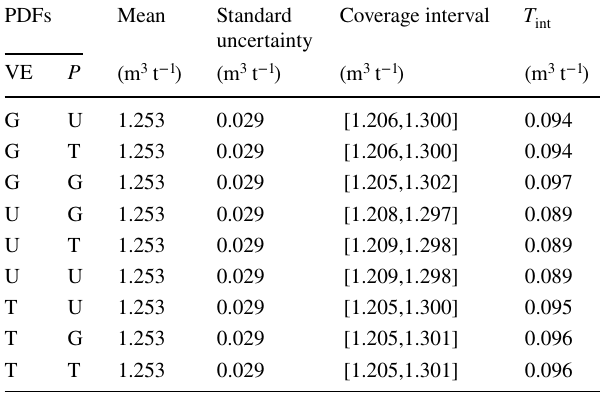
Table 2 Measurement results for the measurand IGE using the GUM S1 method